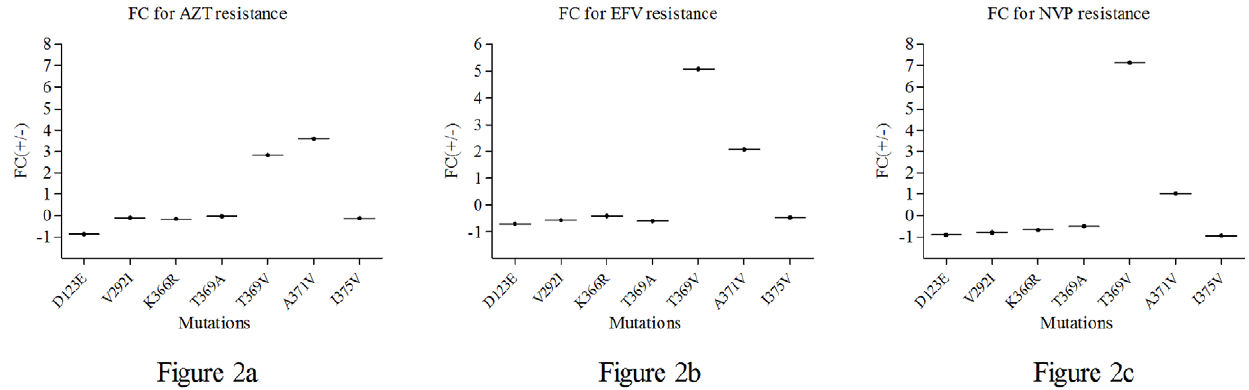
Figure 2. Relationship between viral replication and antiviral drugs at various concentration. The effect of the drugs AZT, EFV and NVP on mutant viruses pNL4-3 T369A and pNL4-3 T369V was illustrated. This map was drawn using Graphpad Prism H software, and the abscissa represents the different drug concentrations (lgnM) and the vertical axis represents the inhibition ratio of drugs on the virus. Figure 2a Relationship between viral replication and AZT concentration. Figure 2b Relationship between viral replication and EFV concentration. Figure 2c Relationship between viral replication and NVP concentration.